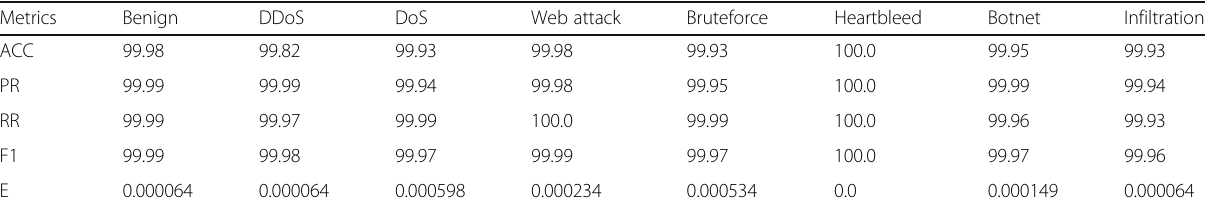
Metrics Bruteforce Heartbleed Botnet